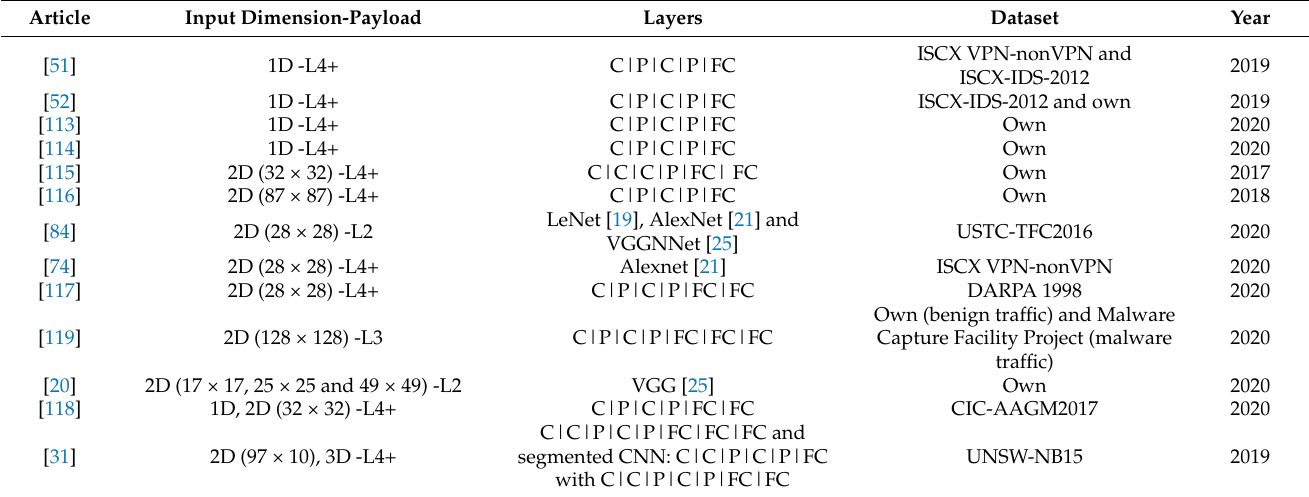
Table 6. Papers that belong to the group extracted